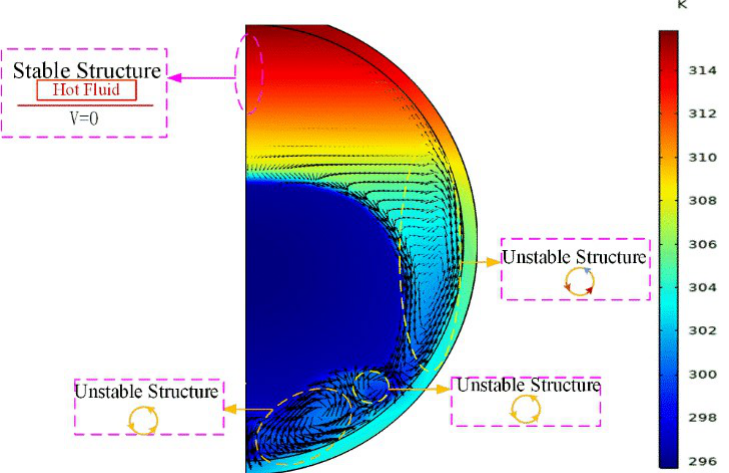
Figure 8. Thermally stable and unstable regions for the constrained melting at 70 min inside the spherical container with R = 31.02 mm and T w = 318.15 K.